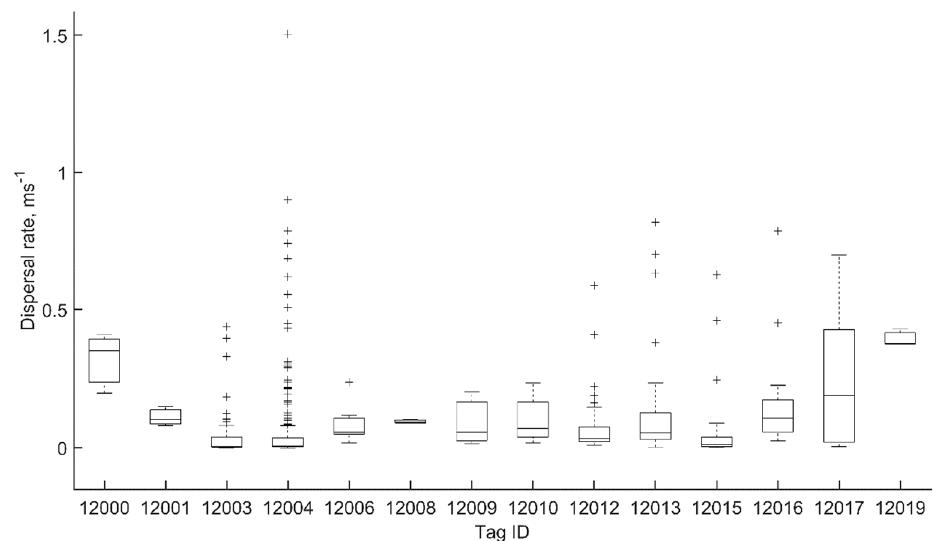
Figure 6. Box–whisker plot of the dispersal rate distribution of acoustically tagged juvenile Chinook salmon in marine waters of Port Walter and Big Port Walter, Alaska, representing the median value (central mark), 25th and 75th percentiles (lower and upper box edges), most extreme data points (whiskers), and outliers (+).